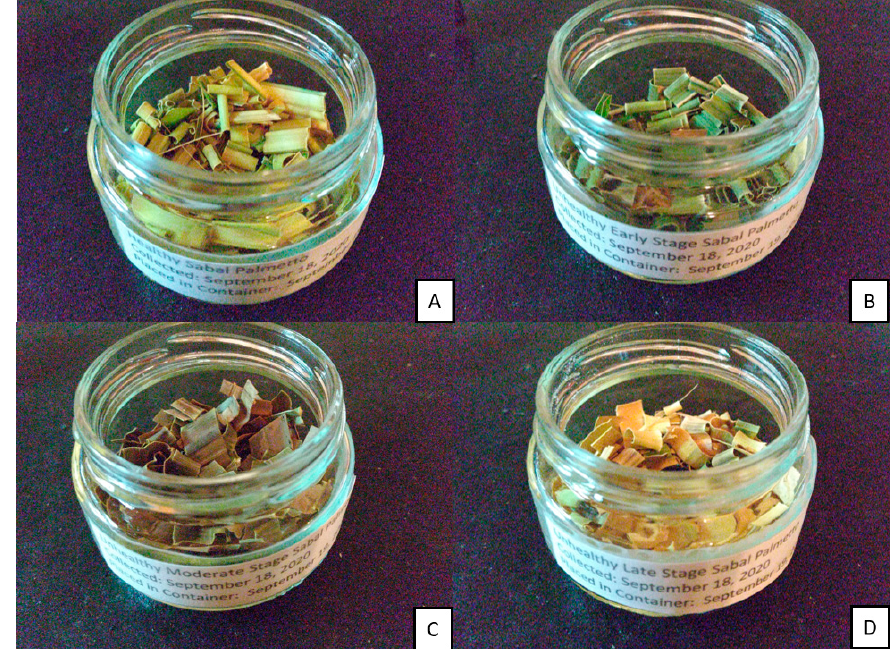
Figure 3. Samples of the Florida Sabal Palmetto. ( A ) healthy/uninfected (HS), ( B ) early-stage (ES), ( C ) moderate-stage (MS), and ( D ) late-stage (LS).